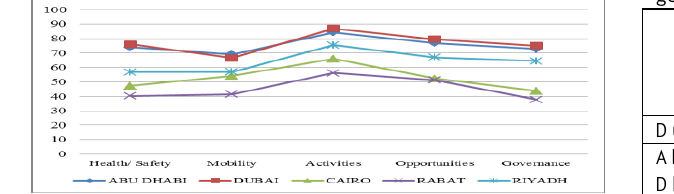
Figure 5: technologies indexes.